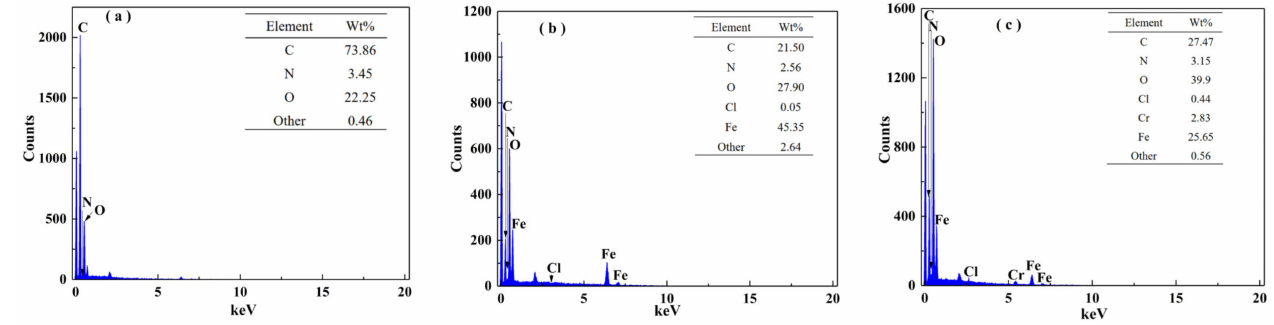
Figure 3. EDS spectra of GOCS ( a ), α –FeO(OH)/GOCS before ( b ) and after ( c ) Cr(VI)